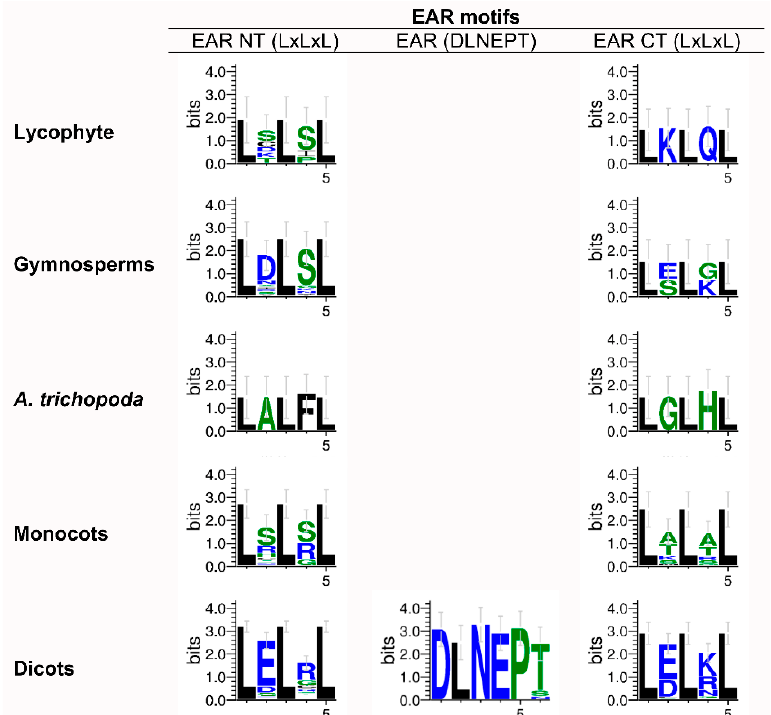
Figure 3. Consensus sequences of EAR motifs for different lineages in the plant kingdom. Logo sequences of the EAR NT motif were obtained from 5, 17, 1, 28 and 118 sequences for lycophyte, gymnosperms, Amborella trichopoda , monocots and dicots, respectively. Logo sequences of the EAR (DLNEPT) motif were obtained from 19 sequences for dicots. Logo sequences of the EAR CT motif were obtained from 1, 2, 2, 27 and 45 sequences for lycophyte, gymnosperms, A. trichopoda , monocots and dicots, respectively. CT, C-terminal region; EAR, ethylene-responsive element binding factor-associated amphiphilic repression; NT, N-terminal region. For more details, see the Materials and Methods section.